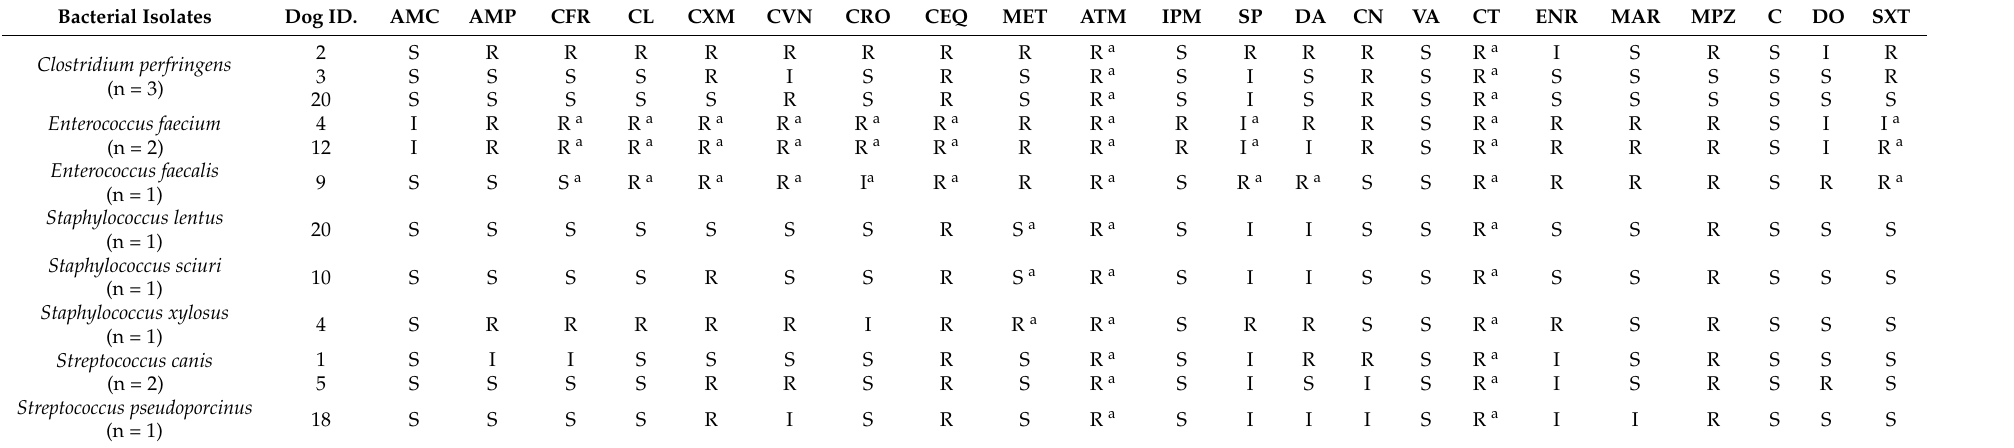
Table 3. Antibiotic sensitivity results derived with Kirby–Bauer method for the Gram-positive strains (n = 12). Bacterial Isolates Dog